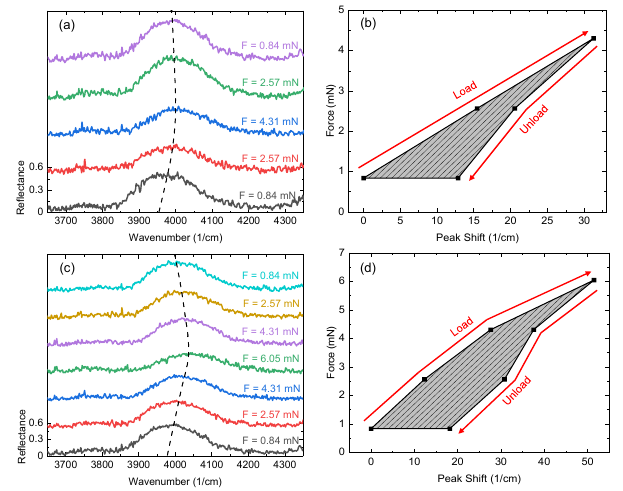
Figure 4. Effect of compressive force on photonic bandgap spectral positioning and amplitude for two cycles. Here the photonic bandgap centered at 4040 cm − 1 in Figure 3 is isolated and studied. The Fourier-transform infrared reflection measurements for this bandgap are given in ( a , c ) for loading and unloading where a shift of the peak center can be seen as well as fluctuations in amplitude. An offset of 0.5 relative reflection intensity is introduced between adjacent curves for visualization. A mechanical hysteresis curve following the compressive cycles of ( a , c ) is plotted in ( b , d ), respectively. Here compressive force is plotted as a function of shift in peak